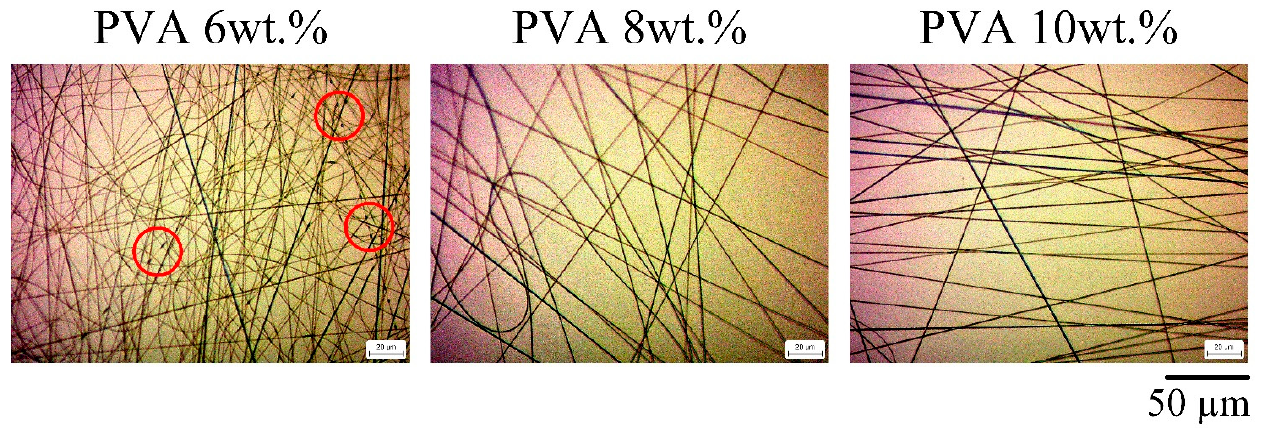
Figure 1. OM images of electrospun fibers at different PVA concentrations and the red circles indicate the location of droplets (magnitude: 500 ×